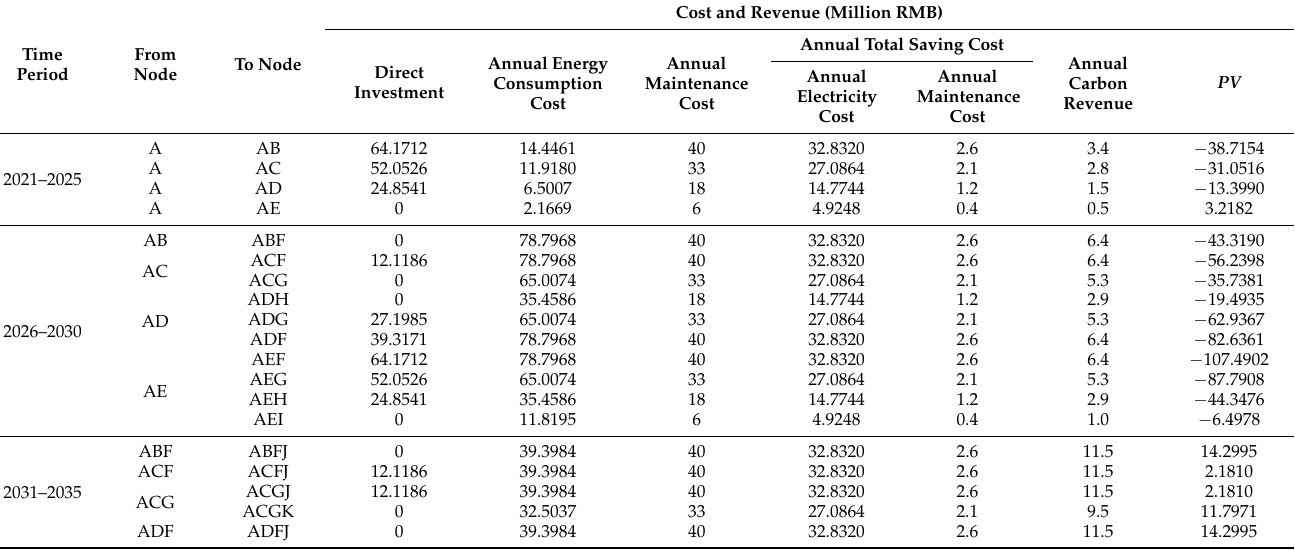
Table A1. Detailed calculations for case